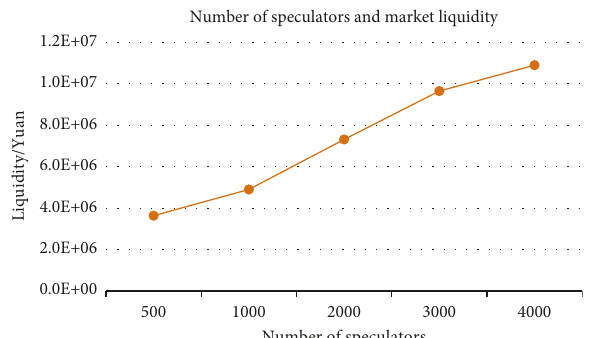
Figure 4: Trends in the number of speculators and market liquidity.